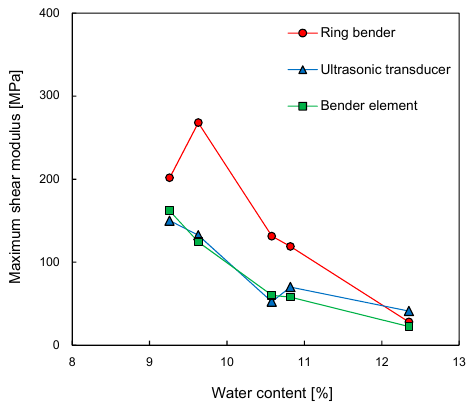
Figure 14. Relationship between water content and maximum shear modulus.